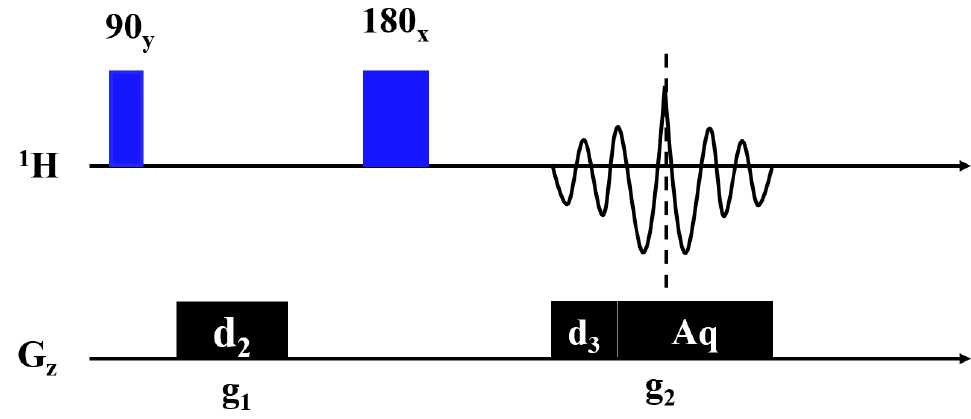
Figure 1. 1D NMR spin-echo imaging sequence. The blue- and black-filled rectangles represent the hard pulses and gradient pulses, respectively. (90 y : 90 degree hard pulse in y direction, 180 x : 180 degree hard pulse in x direction, d 2 : the duration of gradient pulse g 1 , d 3 : the duration of gradient pulse g 2 , Aq: acquisition time )In order to collect a complete echo signal and avoid redundant noise, the durations can be set to: d 2 = (d 3 + aq)/2.